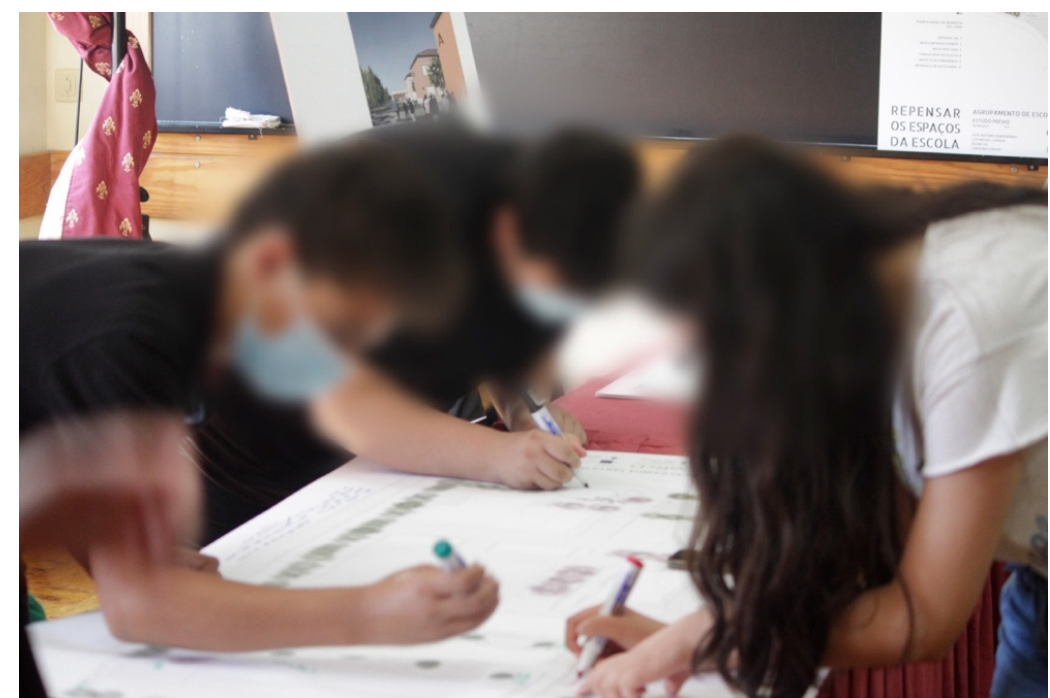
Figure 10. School Assembly in Escola Básica Rainha Santa Isabel (EBRS). Table 3. Sequential development of the implementation of S3S in the pilot study. Stages